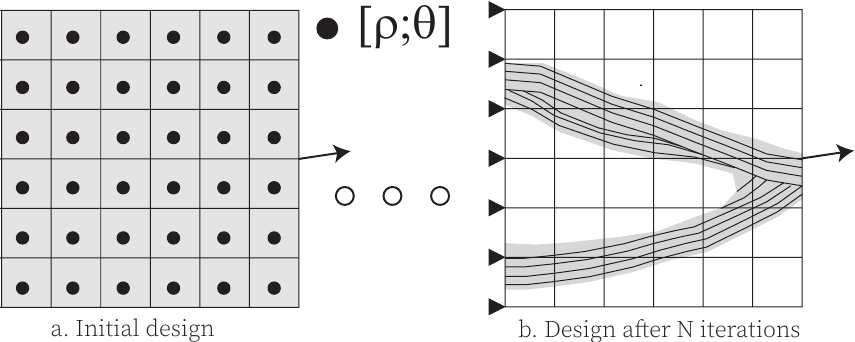
Figure 2. Illustration of DTO considering anisotropic material via fiber orientation